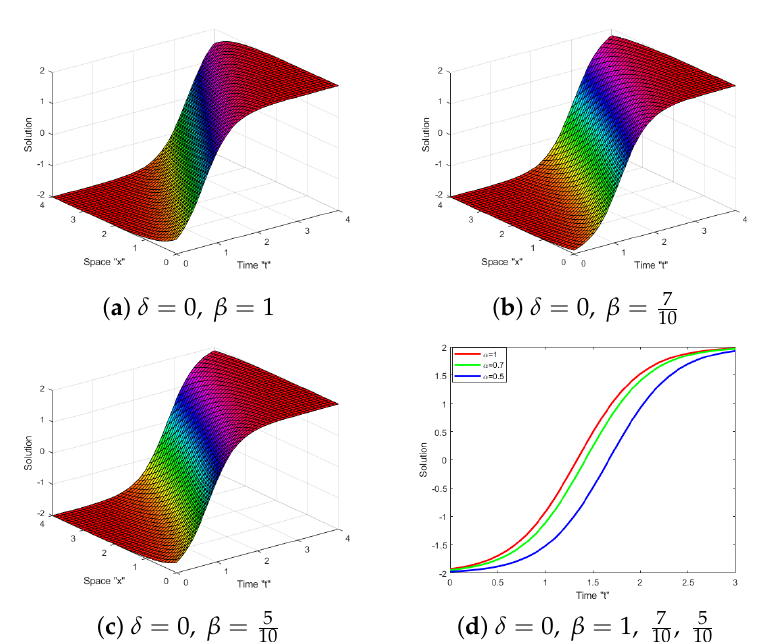
Figure 3. ( a – c ) Three-dimensional graph of Equation (21) with δ = 0 and different values of β = 1, 7 , 5 ( d ) two-dimensional graph of Equation (21) with different values of β = 1, 7 10 10